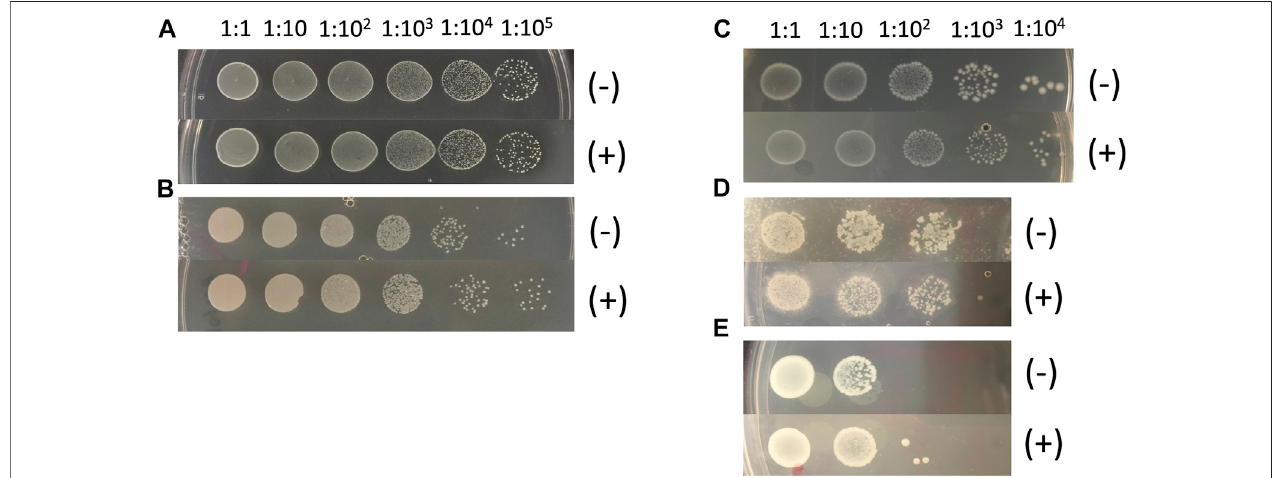
FIGURE 5 | Mifepristone has no detectable antibacterial properties in vitro . Five abundant bacterial species were puri fi ed from single colonies. The colonies were produced by plating extracts of middle-age mated females, using the strain with the largest magnitude response to mating and to mifepristone (progeny of w[1118] X y; Elav-GS ).Bacterialspeciesidentitywasdeterminedbysequencingbacterial16SDNA.Over-nightliquidculturesoftheindicatedbacterialspecieswereseriallydilutedas indicated,and2 μ Laliquotswerespottedontocontrolplates(-),andplatesadjustedto200 μ g/ml fi nalconcentrationmifepristone(+). (A) Lactobacillusplantarum . (B) Acetobacter sicerae. (C) Enterococcus faecalis . (D) Paenibacillus glucanolyticus . (E) Serratia rubidaea